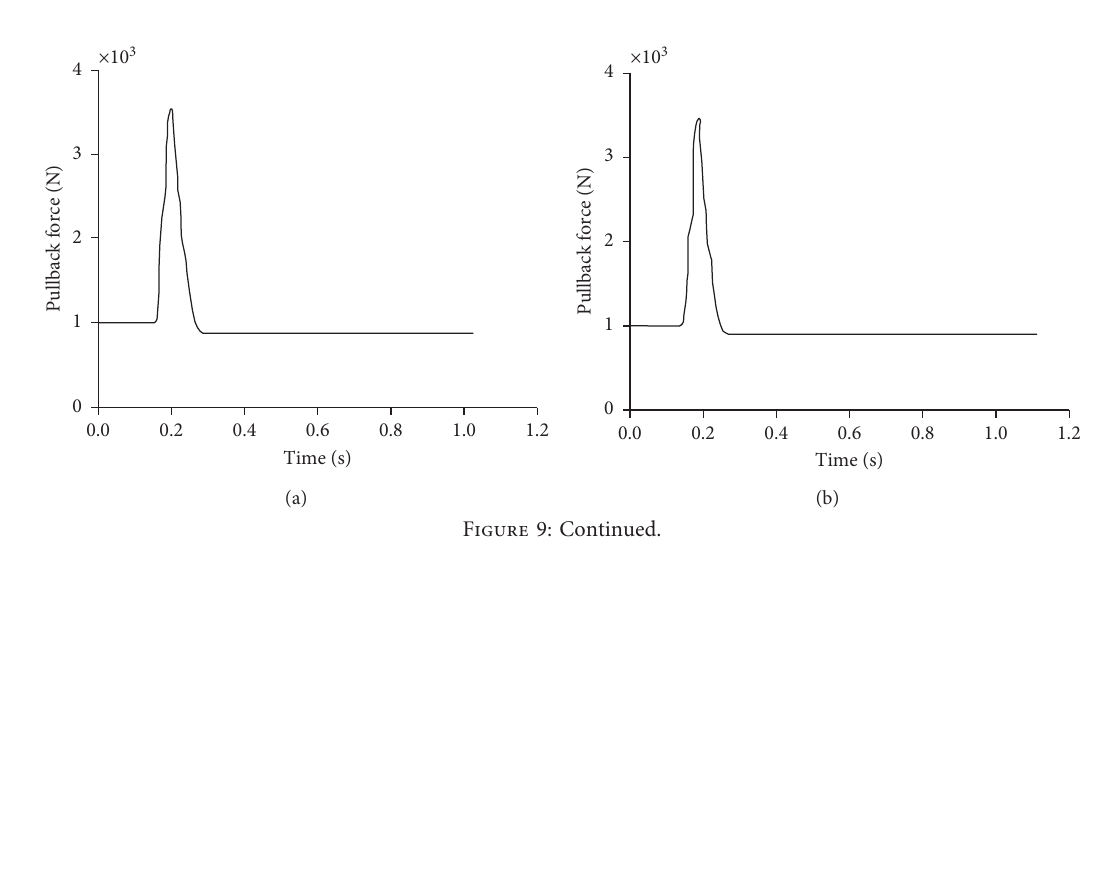
Figure 8: Stress diagram under different radius of curvature.